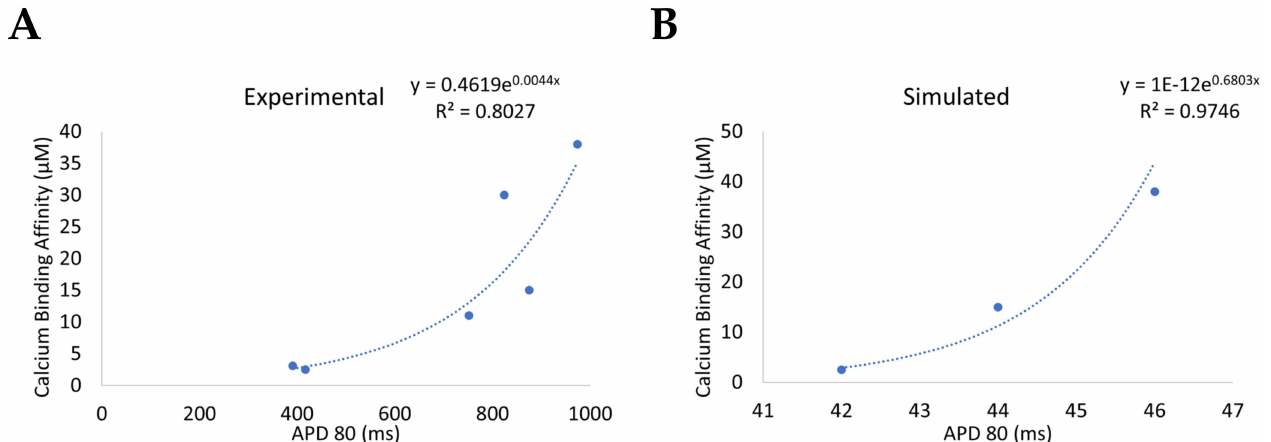
Figure 16. APD80 and calcium binding affinity show a monotonic non-linear relation correlation coefficient. ( A ) Experimental data of APD80 at 0.5 Hz pacing in Guinea pig ventricular myocytes from [1,31,61]. ( B ) Simulated rat ventricular myocyte data of APD80 at 1 Hz pacing from this